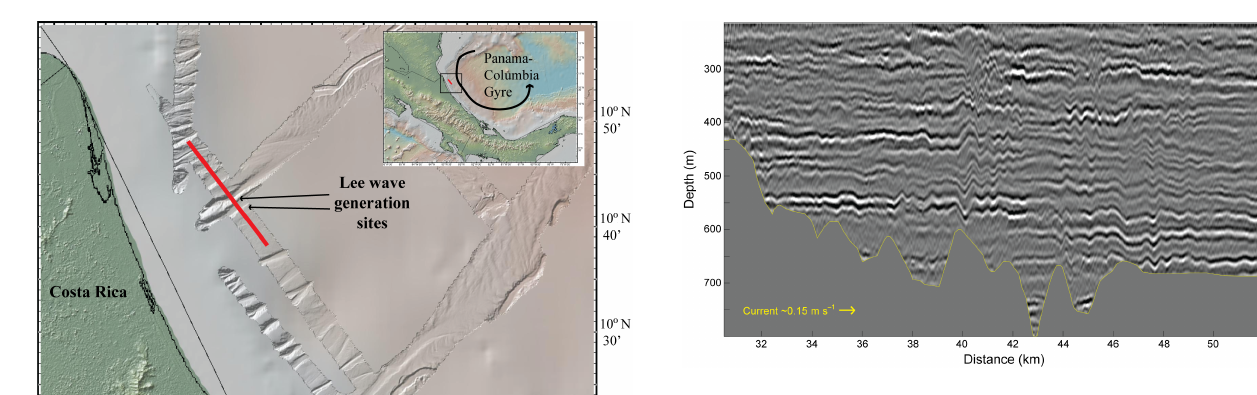
Figure 2. Seismic image of line Limon1 shows two lee wave struc- tures as continuous vertical displacements at 40 and 45km. The lee wave at 40km is significantly more pronounced and has a vertical displacement of 35m. The lee wave at 45km has a smaller vertical disruption to fine structure, but exhibits a larger lateral extent dis- playing coherent vertical disruptions from ∼ 44 to 46km. Nearer the sea surface, as the lee waves approach the well-stratified lower thermocline, between 200 and 350m depth, the vertically contin- uous nature of the lee wave breaks down into higher horizontal wavenumber reflections that we show to be turbulent